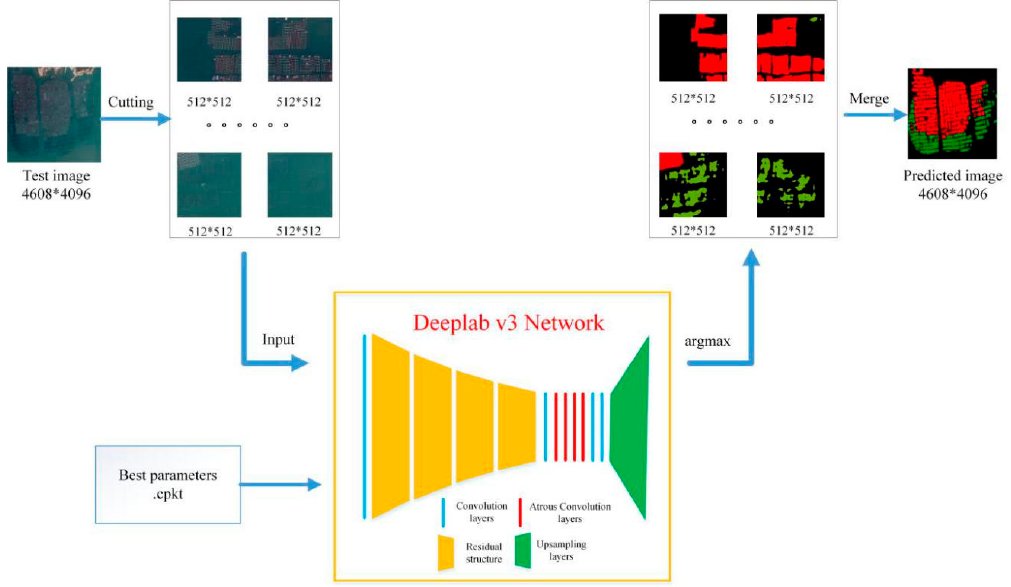
Figure 9. The prediction flow chart of OAE-V3 model.